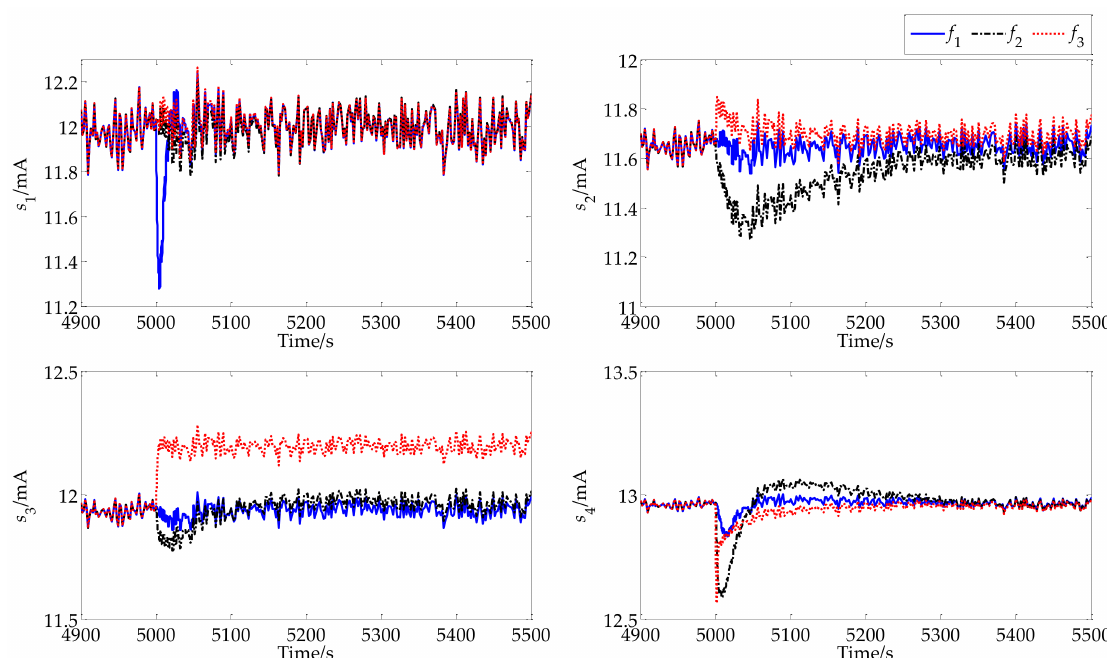
Figure 5. Responses of sensor outputs under faults f i ( i = 1, 2, 3); s 1 : normalized nuclear power n r , s 2 : primary helium flowrate G h , s 3 : average helium temperature T cav , s 4 : average temperature of the OTSG secondary coolant T sav